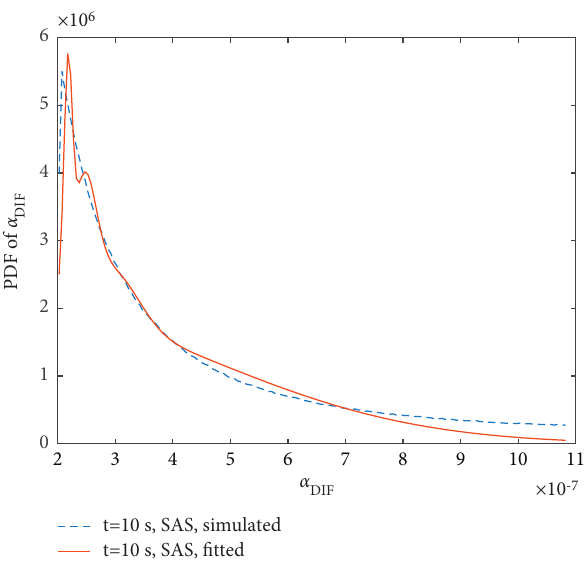
Figure 12: The PDF of α and its fitted function (with t � 10s, SAS, and ϵ � 3 . DIF